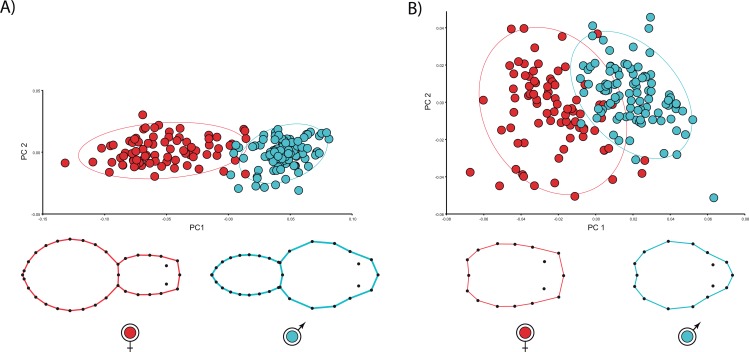
Principal Component Analysis of shape variation. (A) body and (B) carapace shapes. Extreme female and male shapes are polarized at the extreme of PC1 (x axis). (A) Males (blue dots) and females (red dots) clearly differ on PC1, which explains most body shape variation (85.7%). (B) Sex differences in carapace shape are also distinct.